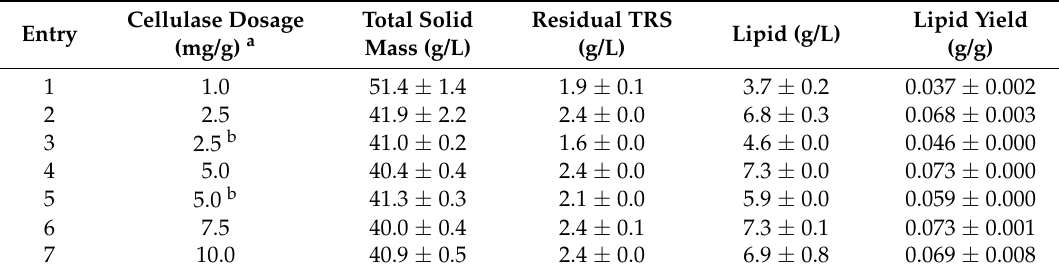
Figure 2. TRS ( a ) and glucose ( b ) evolution profiles of lipid production at 30 °C with various amounts of cellulase. #: without prehydrolysis. Table 2. The results of lipid production at 30 ◦ C with various amounts of